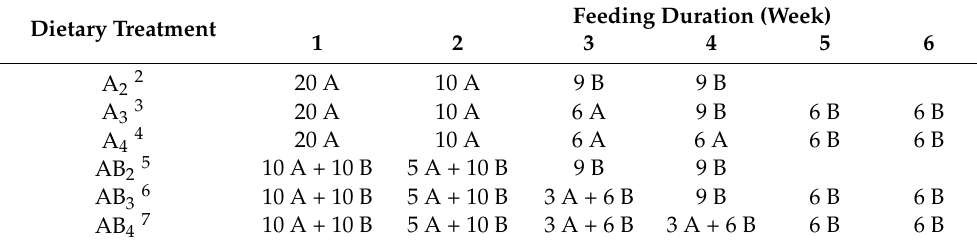
Table 3. Cont. Dietary